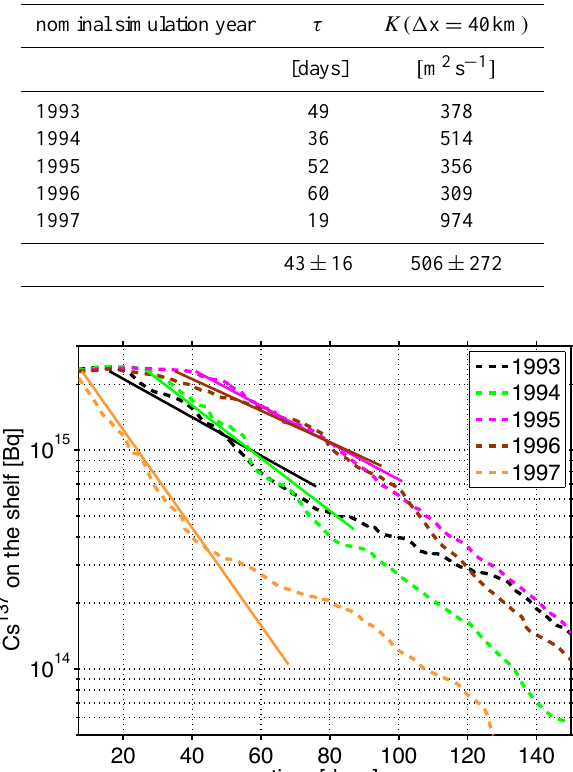
Table 2. Decay timescales ( τ ) derived from fitting Eq. (8) to sim- ulated 137 Cs content on the shelf (Fig. 15). Diffusivities ( K ) are then calculated with Eq. (9) assuming a realistic shelf width ( 1x ) of 40km.